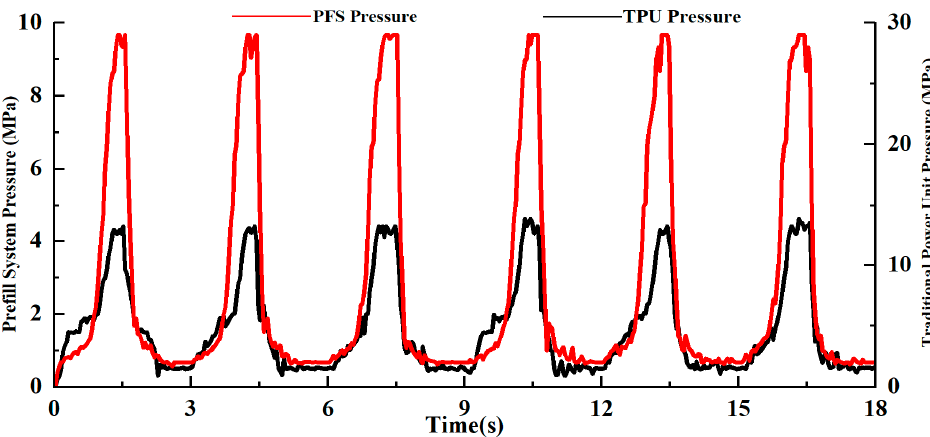
Figure 7. Output pressure of the prefill system and the main power unit during constant forging.